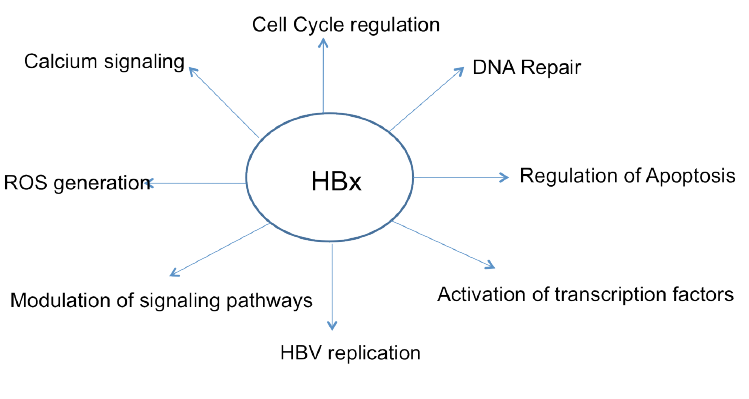
Figure 2. Various functions of HBx. HBx is known to modulate a number of